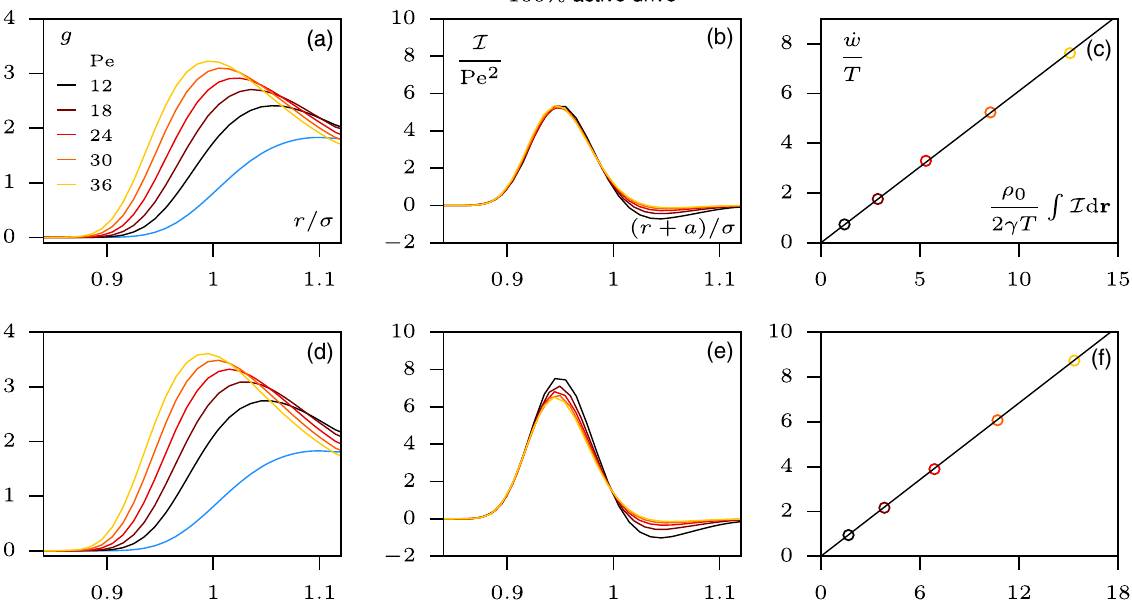
FIG. 4. Connecting dissipation and structure for a liquid where 100% of particles are driven by an active force. (Left) Density correlation g as a function of interparticle distance r= σ . The blue solid line corresponds to the equilibrium correlation function g Pe ¼ 0 . (Middle) Deviation from equilibrium correlations I ¼ ½ð ∇ v Þ 2 − T ∇ 2 v (cid:2)ð g − g where a ð Pe Þ is a fitting parameter. The data almost collapse into a master curve for each row, namely, at a given τ . (Right) Parametric plot of the rate of work _ w=T and the integrated deviation from equilibrium correlations ρ 0 black solid line with slope α is the best linear fit, and the marker colors refer to the same P´eclet values as in the left and right columns. Simulation details are in Appendix A. Parameters: f τ T= ð γσ 2 Þ ; α g ¼ f 2 × 10 − 2 ; 1 . 22 g (a) – (c) and f 5 × 10 − 2 ; 1 . 14 g (d) –